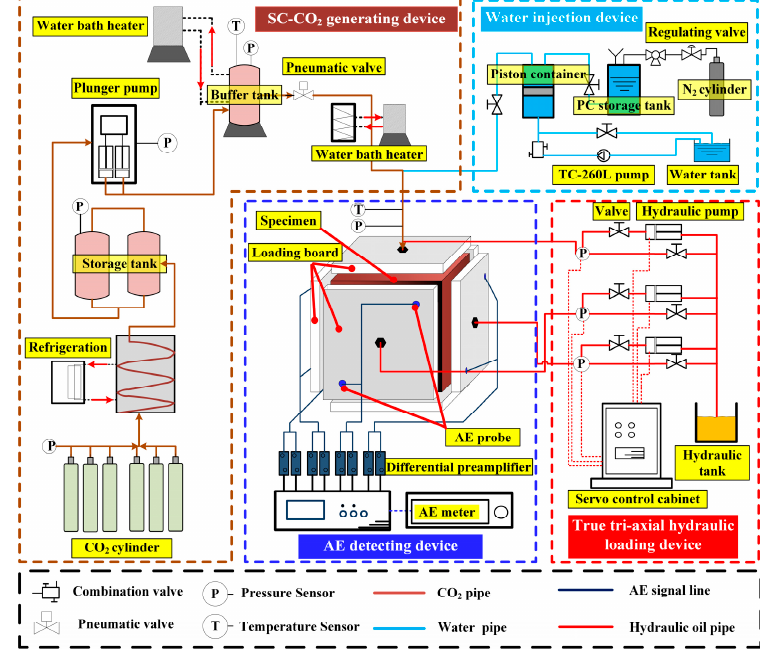
Figure 1. True tri-axial SC-CO 2 fracturing and hydraulic fracturing system.